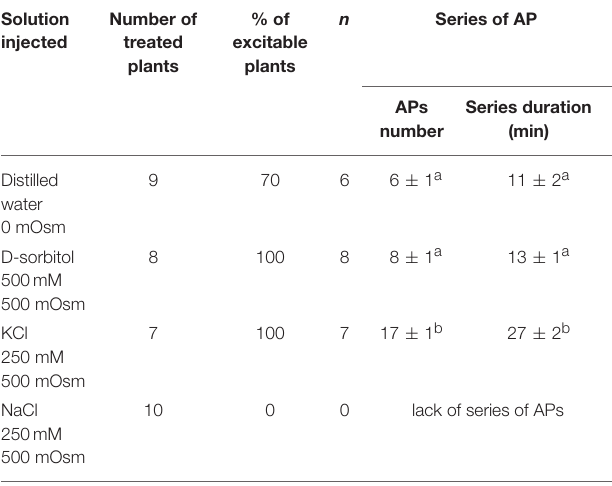
TABLE 3 | Parameters of osmotic and salt-induced series of action potentials in 3-week old Helianthus annuus . Solution Number of injected treated